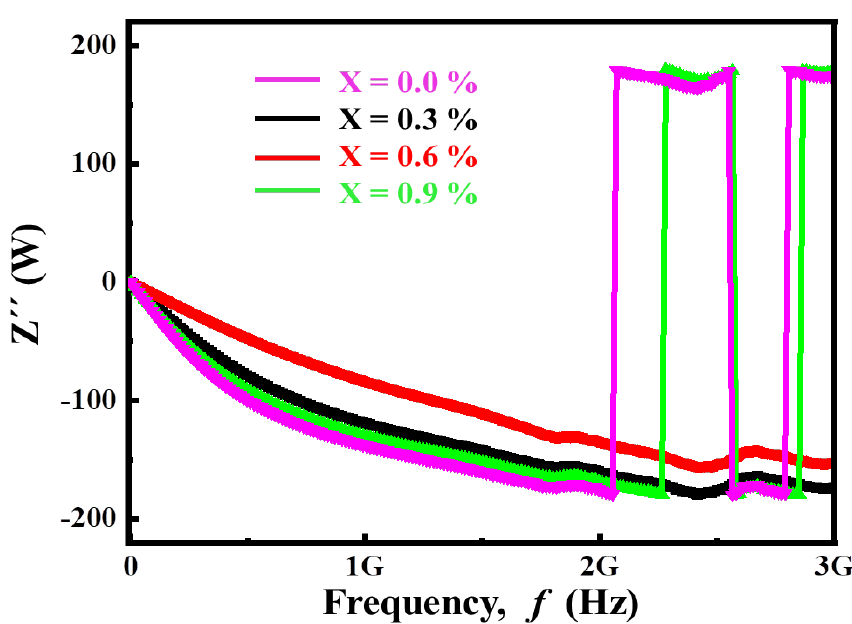
Figure 6. Frequency-dependent variation of real part of impedance for (Ba 1−x Ca x )Ti 4 O 9 (x = 0.0, 0.3, 0.6 and 0.9) sintered ceramics at 1000 °C for 4 h.